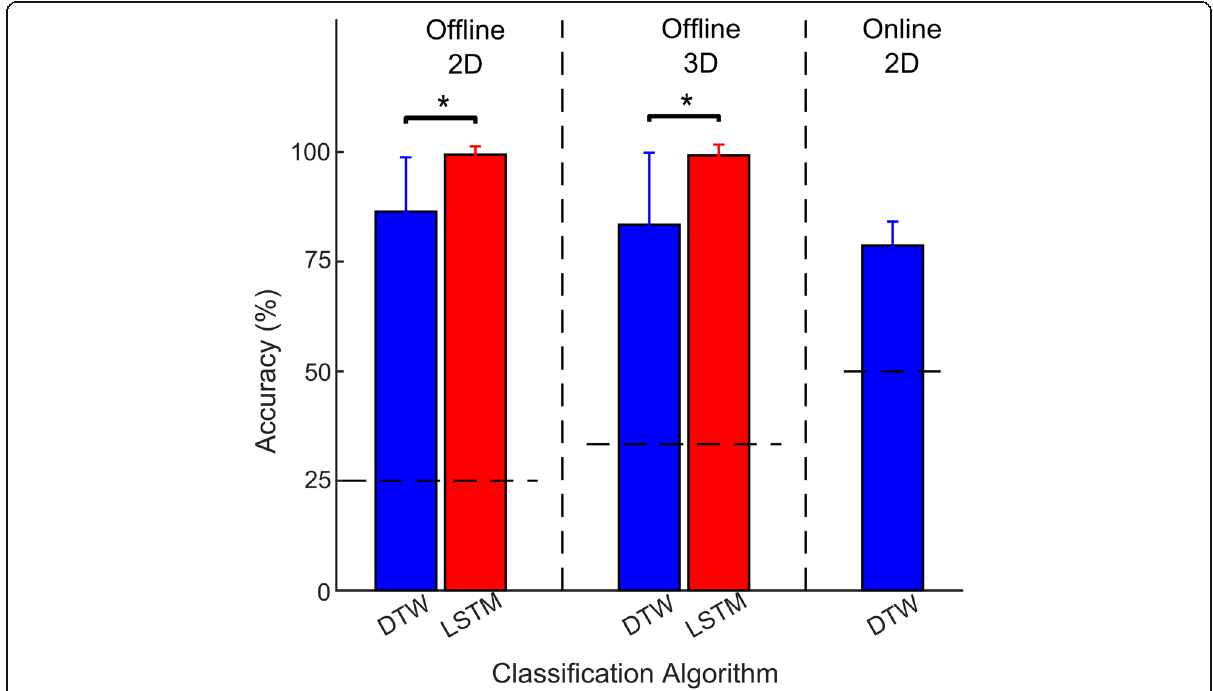
Fig. 2 Bar graphs comparing classification accuracies (Mean ± SD) using two machine learning algorithms: DTW and LSTM. Performance was evaluated using both offline (2D & 3D) and online (2D only) arm trajectories. Statistical significance threshold was set at p < 0.05. The horizontal dashed lines represents the chance level (= 1/number of classes) under each